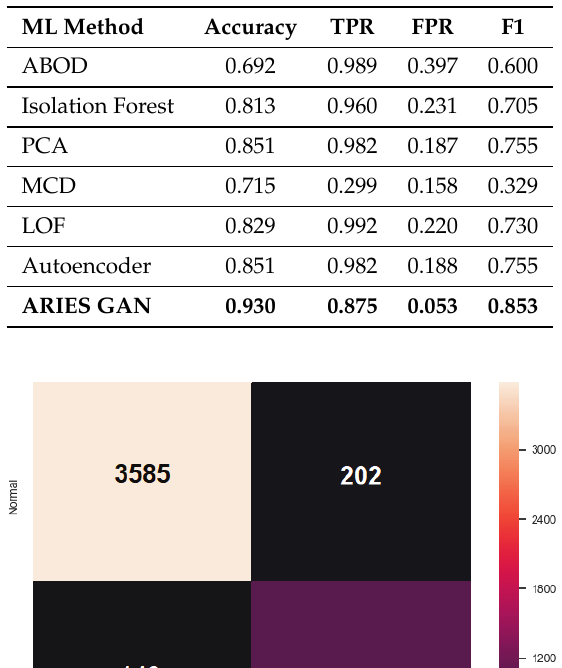
Table 4. Evaluation Results of the Third ARIES Detection Layer.